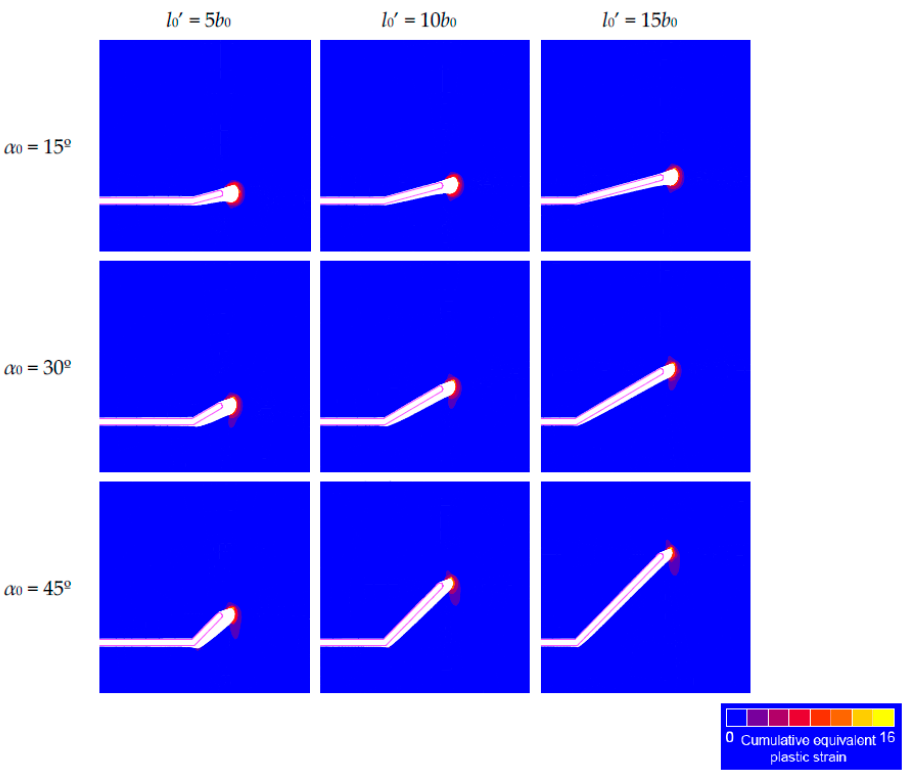
Figure 7. Initial and deformed crack tips after 20 cycles (with the cumulative equivalent plastic strain in color) for the kinked crack tip with Δ K = 25 MPam 1/2 .